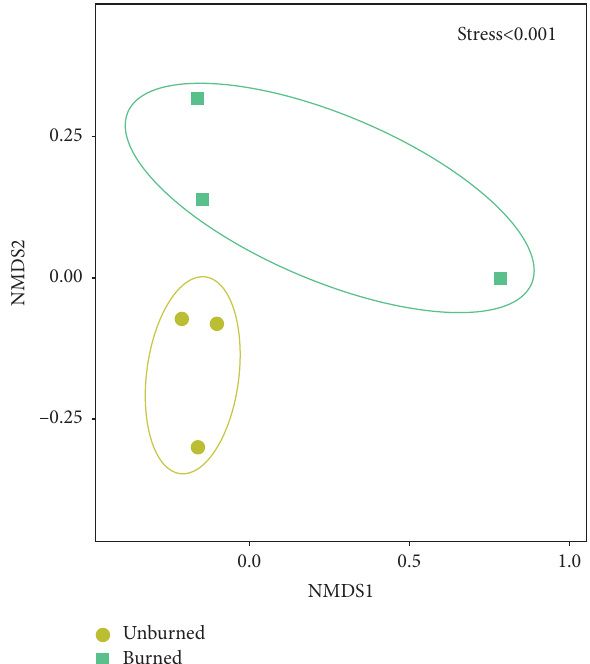
Figure 2: Bacterial community composition of unburned and burned sugarcane plots based on nonmetric multidimensional scaling (NMDS) analysis, where stress amounted to <